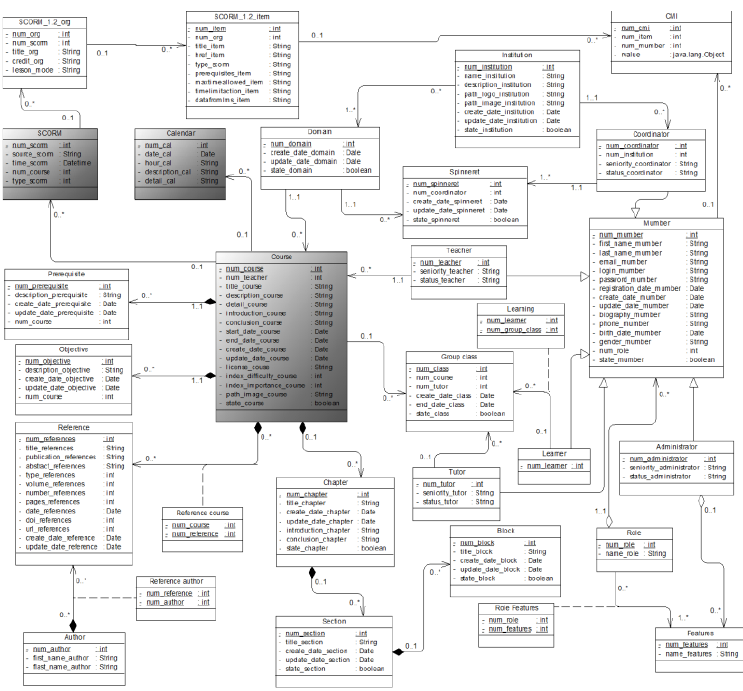
Fig. 2. Class Diagram of disciplinary information space for